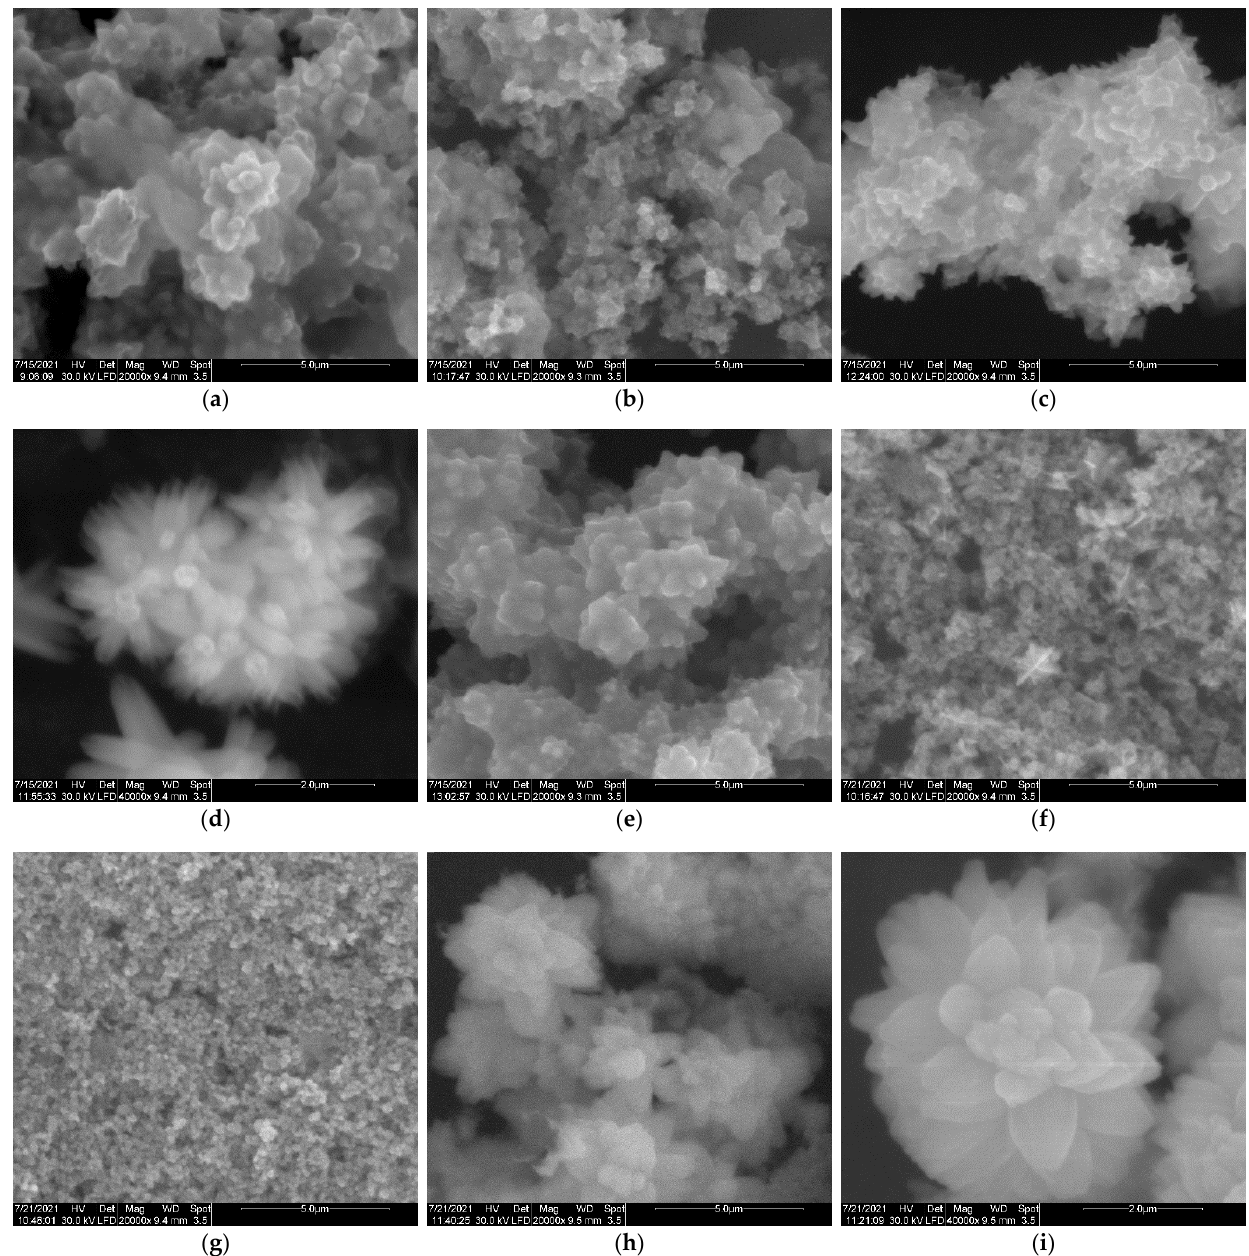
Figure 3. SEM images of ZnO nanoparticles obtained under various conditions (Table 1) in microwave-assisted synthesis. ( a ) ZnO_Am1; ( b ) ZnO_Am2; ( c ) ZnO_Am3; ( d ) ZnO_Am3 high magnification; ( e ) ZnO_Am4; ( f ) ZnO_Arg1; ( g ) ZnO_Arg2; ( h ) ZnO_Arg3; ( i ) ZnO_Arg3 high magnification.